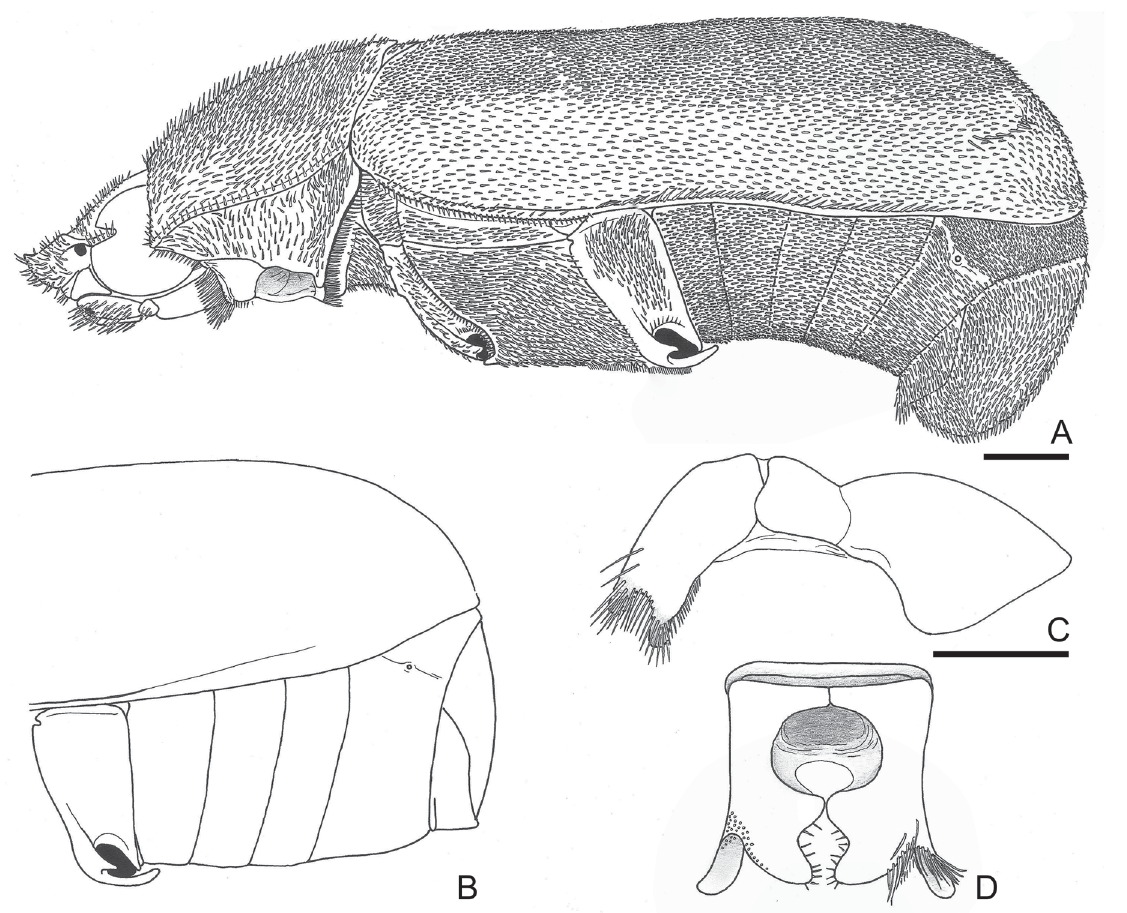
Fig. 1. Agaocnemis pruina Moser, 1918. A . Male habitus, lateral (without some appendages). B . Female abdomen lateral detail. C–D . Aedeagus (lateral, parameres apex). Scale bars = 1